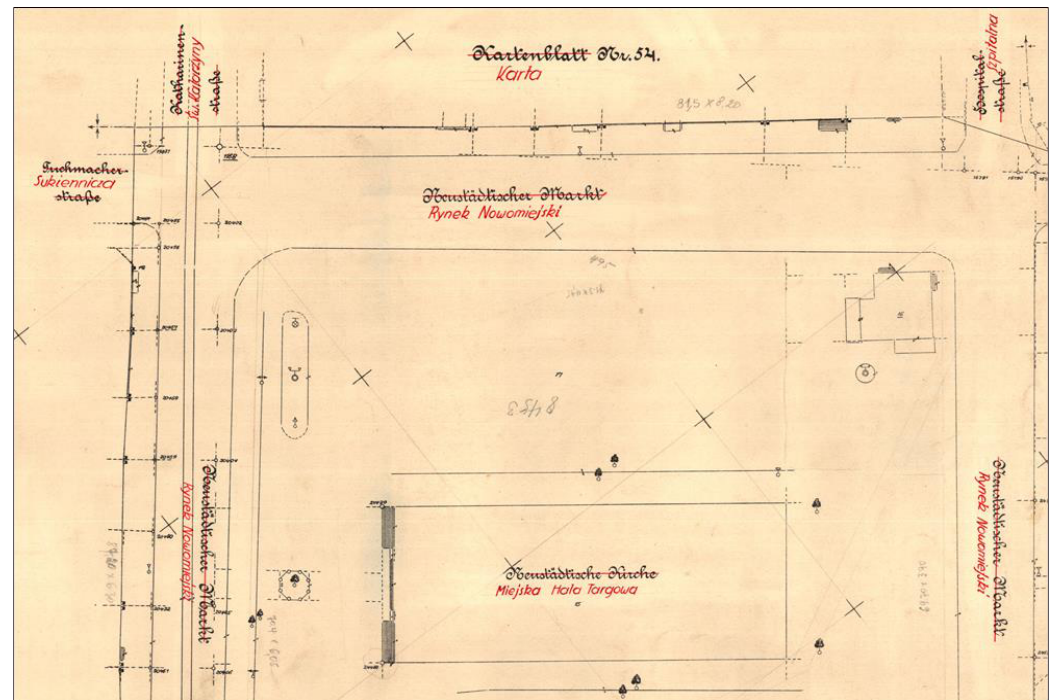
Figure 10. A fragment of the cadastral map of Toruń showing the northern part of Nowomiejski Square and the German (black) and Polish (red) street names. Source: Gemarkungskarte der Stadt Thorn, Blatt 53, State Archives in Toruń.